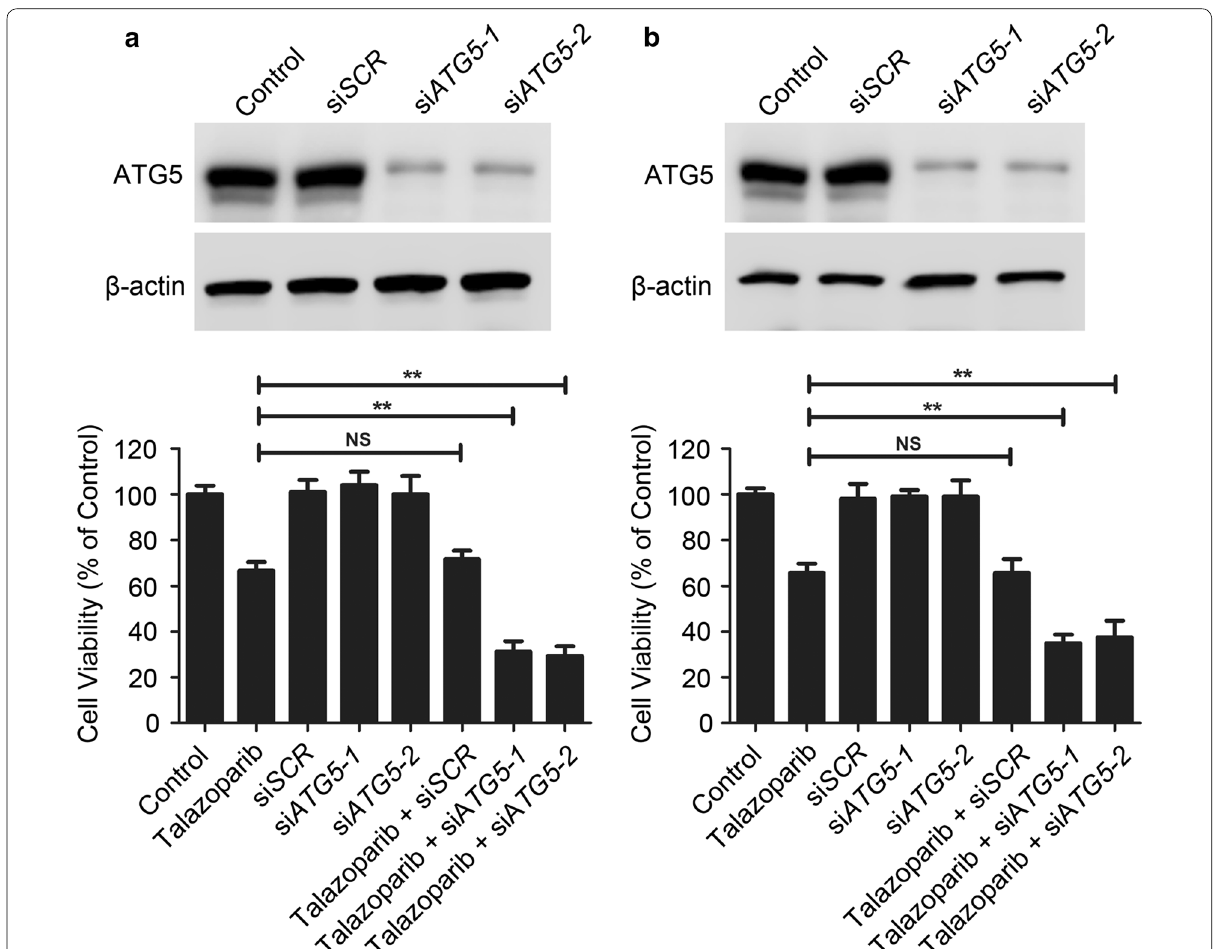
Fig. 6 Knockdown of ATG5 enhanced the cytotoxicity of talazoparib in CML cells. P#1 ( a ) and P#2 ( b ) were transfected with ATG5 siRNA for 48 h, and immunoblot analysis was used to determine the protein level of ATG5. Cell viability was measured by CCK-8 assay ( N significance; ** P <